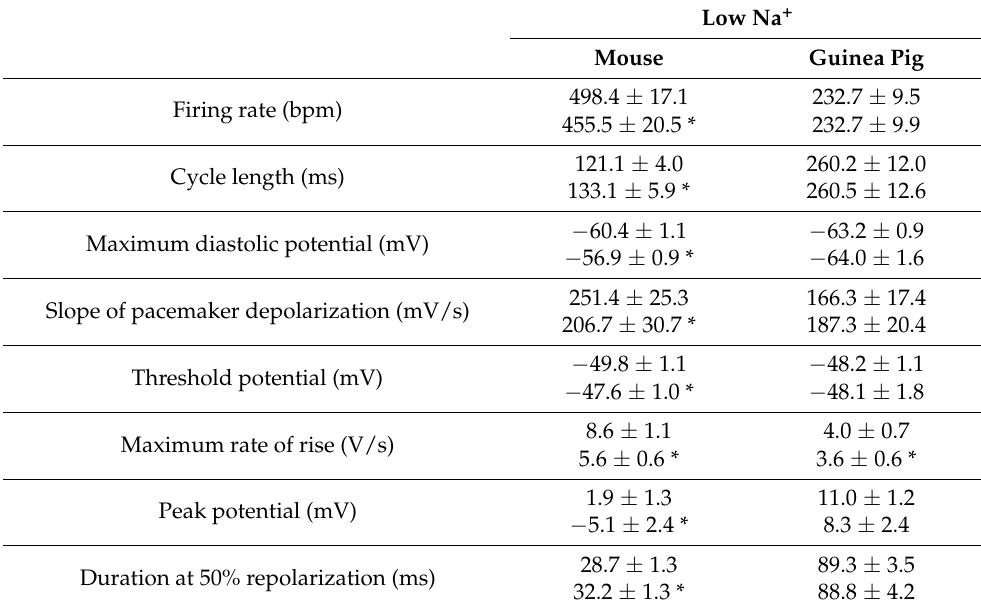
Figure 3. Effect of low Na + solution on the sinus node action potential of the mouse and guinea pig. Typical traces before (black lines) and after (red lines) rapid change of the extracellular solution to low Na + solution. Table 3. Action potential parameters before and after the rapid change of the extracellular solution to low Na + solution.